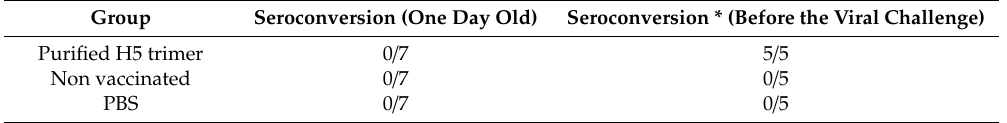
Table 1. Immunological analyses of birds vaccinated with purified H5 trimers by a commercial competitive ELISA. Chicken sera were immediately collected before the viral challenge. * Some sera were fatty and could not be examined by a commercial competitive